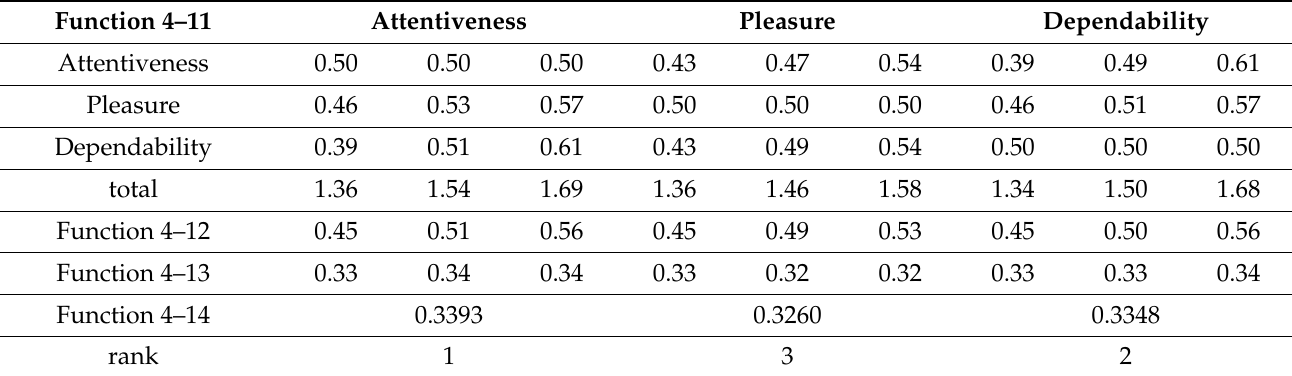
Table A6. Aviation companies’ weights of attributes of the emotional value.